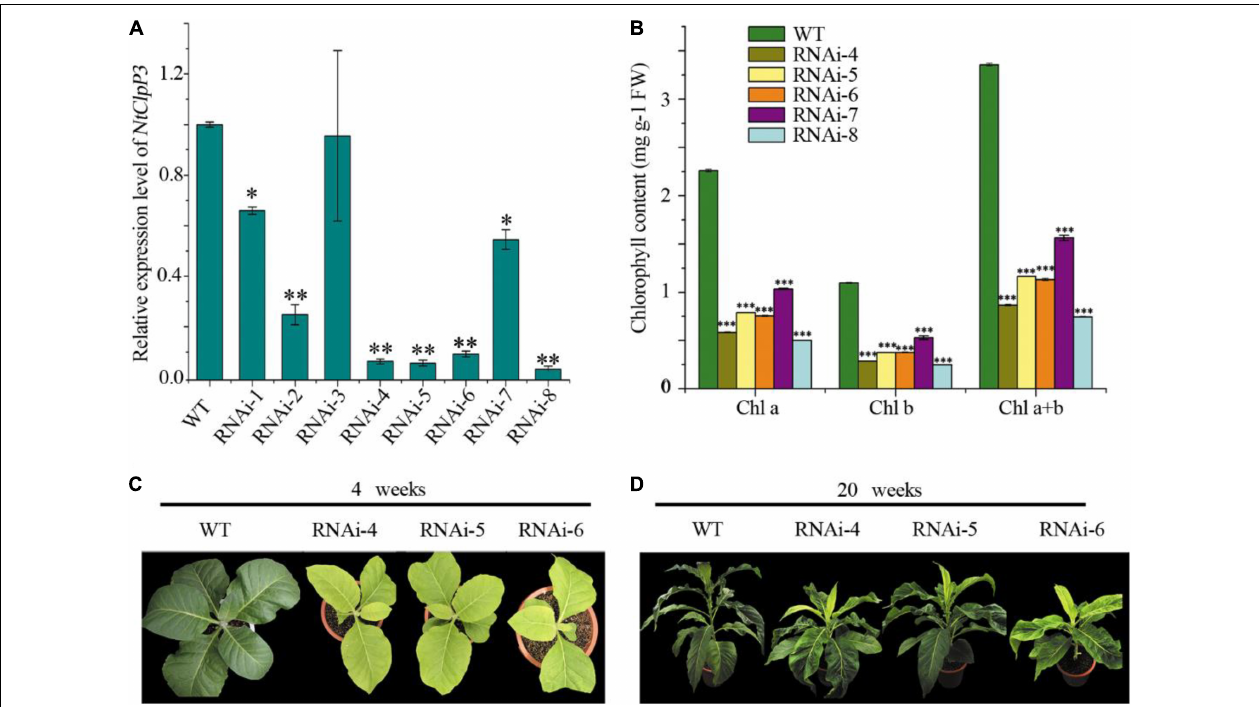
FIGURE 3 | Transcriptional and morphological alterations of transgenic tobaccos with suppressed NtClpP3. (A) Transcript levels of NtClpP3 in wild-type (WT) and transgenic tobaccos. (B) Chlorophyll contents in WT and transgenic tobaccos. (C) Differences in leaf appearances between 4-week-old WT and transgenic tobaccos. (D) Morphological differences between 20-week-old WT and transgenic tobaccos. One way-ANOVA analysis was performed using SPSS19 software. ∗ p < 0.05; ∗∗ p < 0.01; ∗∗∗ p < 0.001.